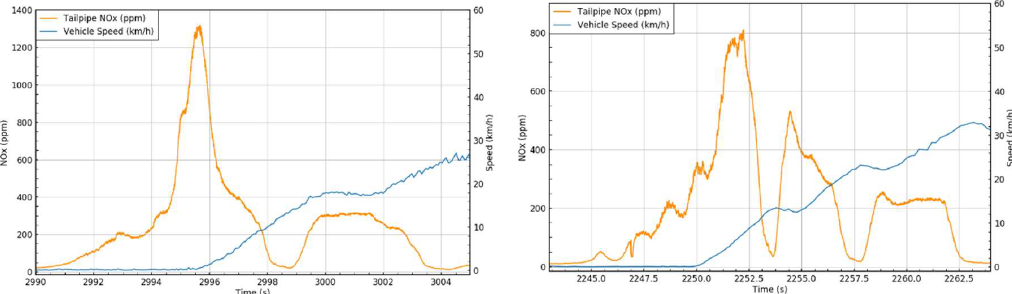
Figure 9. Two pulling away events in the Euro V bus, showing the short ‘spike’ in NO x emissions associated with the initial pull away.